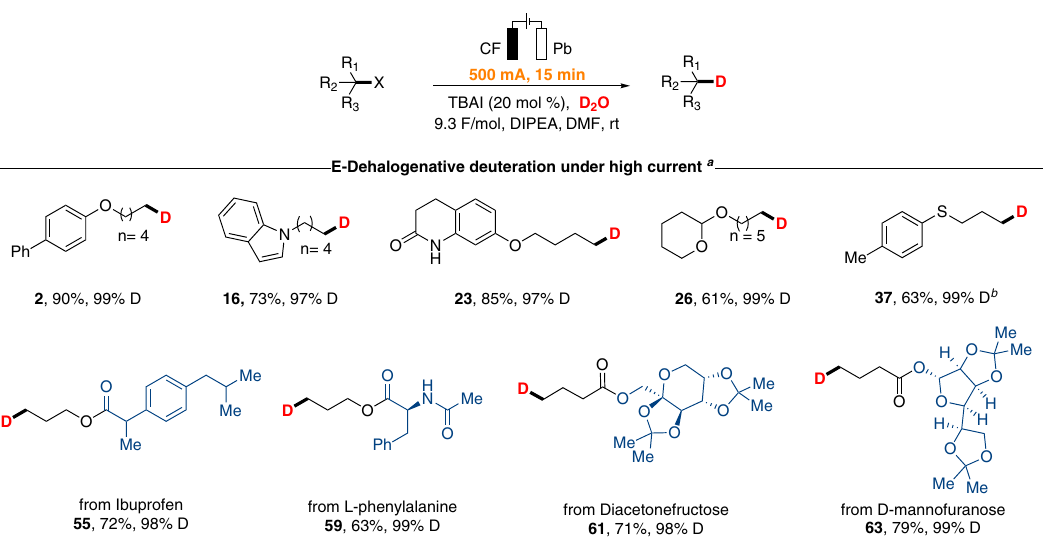
Fig. 3 Fast electrochemically driven dehalogenative deuteration under high current. a Reaction conditions: alkyl bromide (0.5 mmol), D 2 O (25.0 mmol), TBAI (20 mol %), DIPEA (1.5 mmol), DMF (5.0 mL) under 500 mA constant current in an undivided cell at room temperature for 15 minutes with carbon felt as anode and lead plate as cathode. Isolated yield of product. b Alkyl chlorides (0.5 mmol) was conducted with graphite felt as anode.